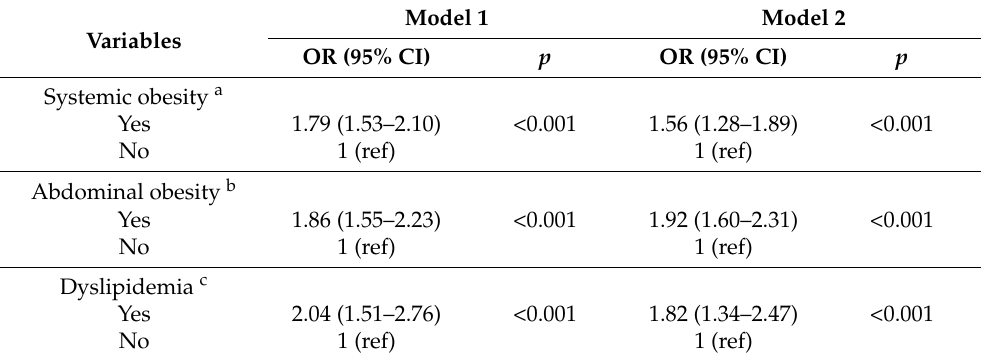
Table 2. Relationship amongst systemic obesity, abdominal obesity, dyslipidaemia and diabetes.